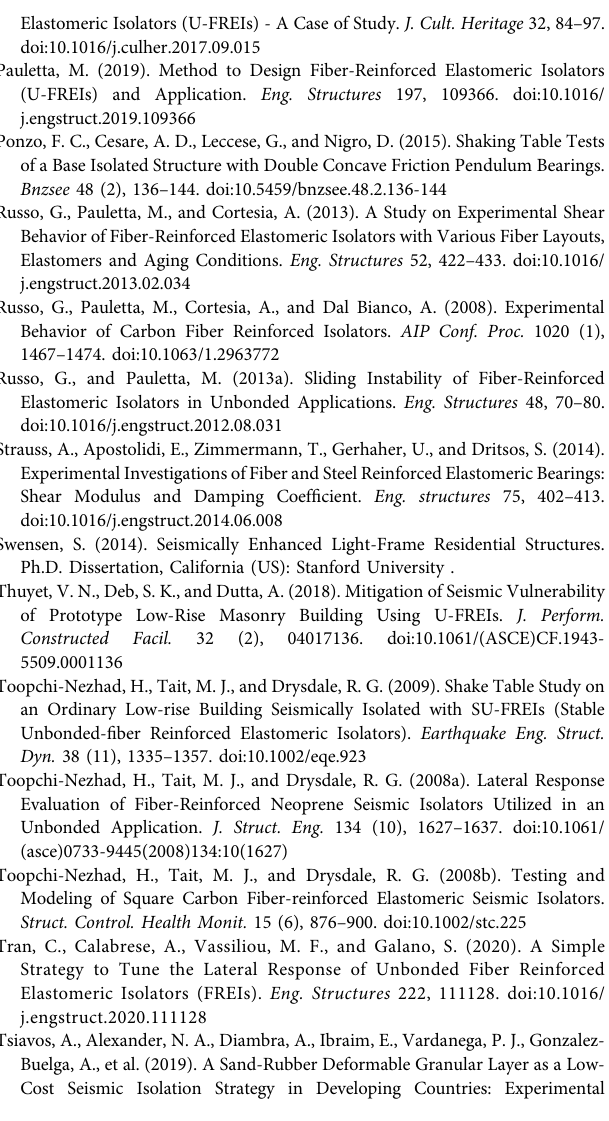
Countries: Shaking Table Tests. Soil Dyn. Earthquake Eng. 146, 106675.